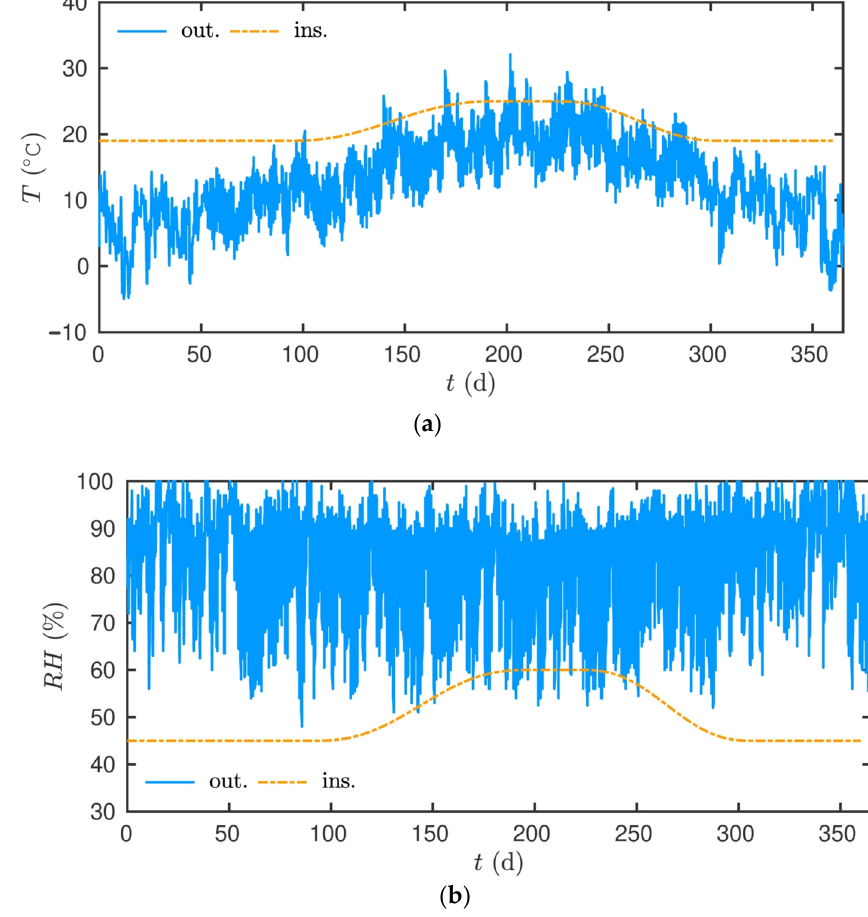
Figure 16. Inside and outside boundary conditions applied to the studied wall: ( a ) Temperature; ( b )